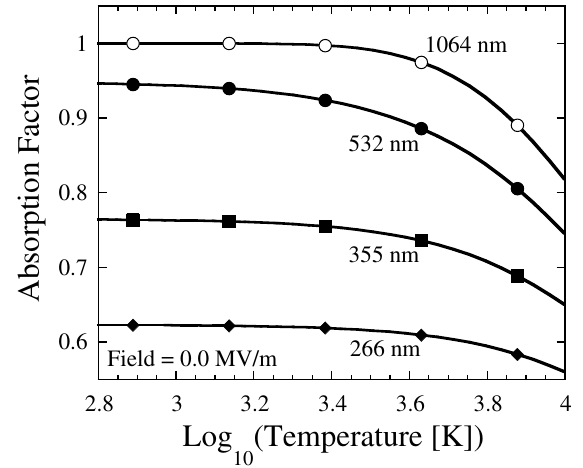
FIG. 2. Fraction of photons absorbed and leading to electron gas and lattice heating, corresponding to the term in square brackets of Eq. (9) for various wavelengths. For (cid:25) (cid:3) 1064 nm , an electron at the Fermi level cannot surmount the barrier after photoabsorption. The decrease at higher temperatures is due to thermal spreading of the electron distribution. The temperature dependence of (cid:18) has not been taken into